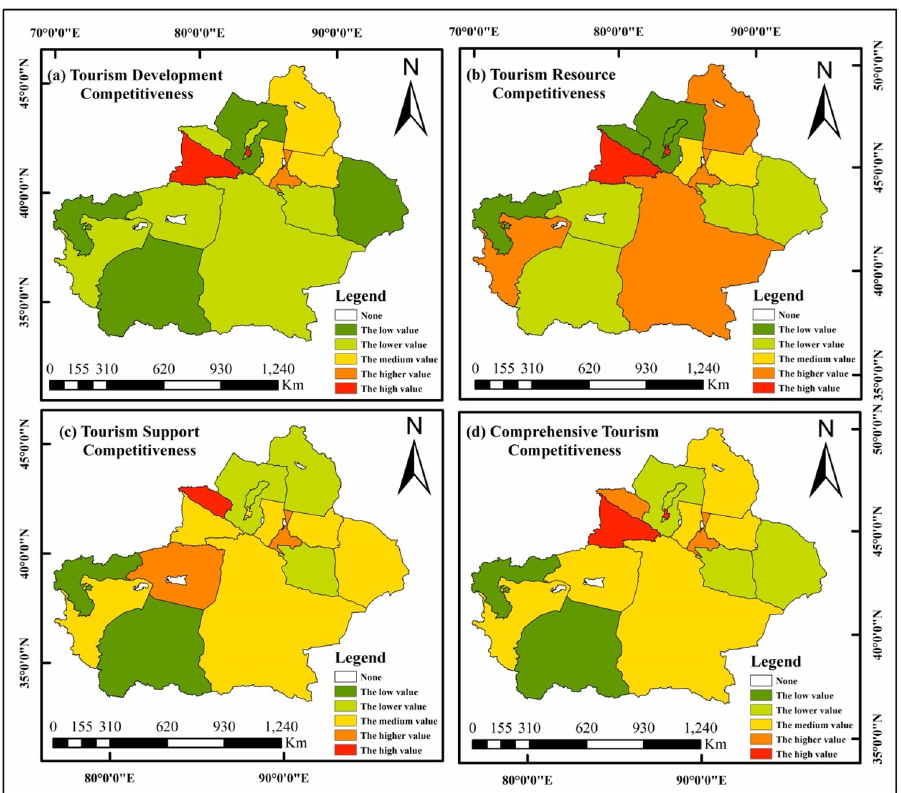
Fig 1. (a-d). Spatial difference analysis of tourism competitiveness in 14 regions of Xinjiang. Based on the results of tourism development competitiveness, resource competitiveness, support competitiveness, and comprehensive competitiveness, the ArcGIS spatial analysis function are used for classification, and the color indicates the strength of competitiveness. The blank area is the Xinjiang Production and Construction Corps, which is not within the scope of statistics. The base layer was downloaded from The Gateway to Astronaut Photography of Earth website (https://eol. jsc.nasa.gov/SearchPhotos/). Map credit: Haijun Liu.